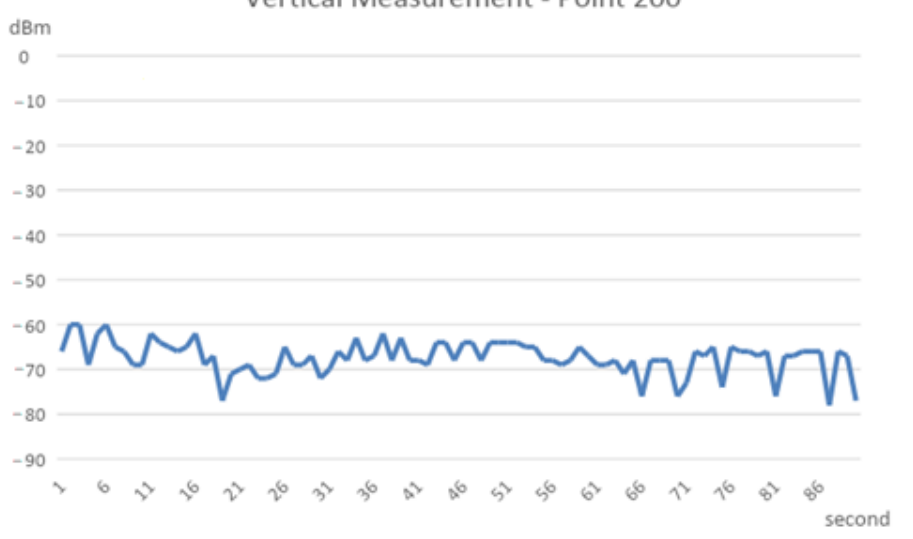
Figure 2. Line chart of the vertical measurement signal.